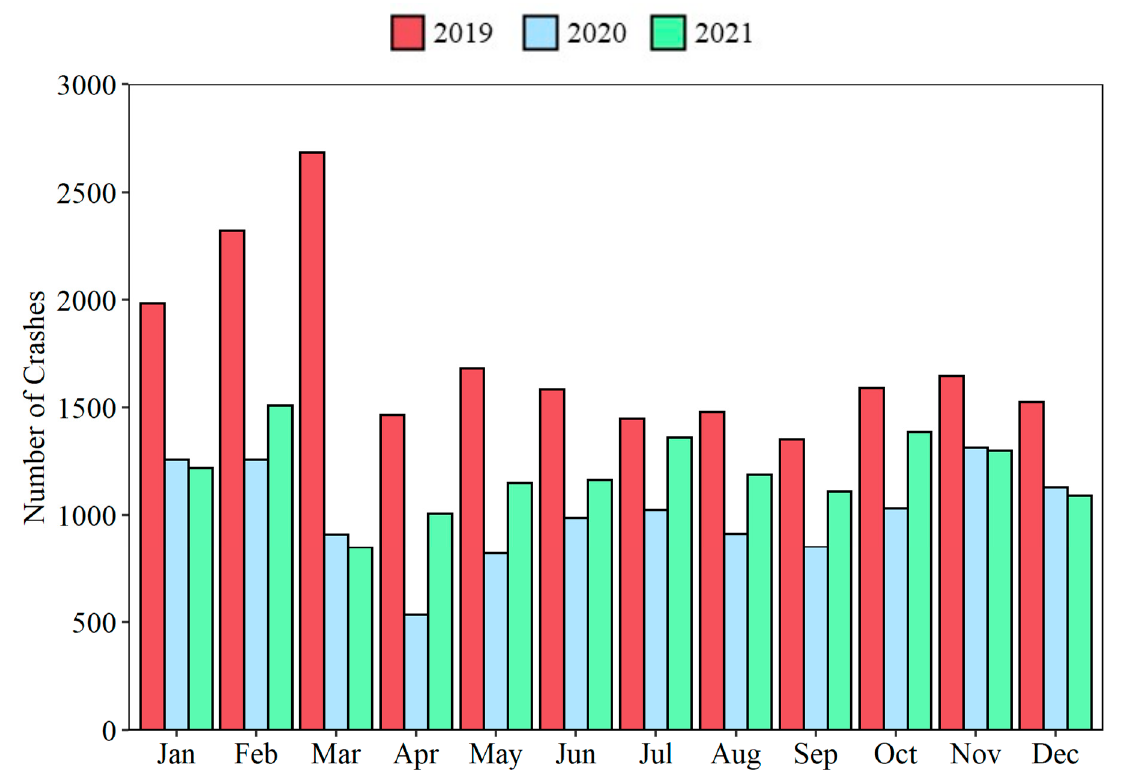
Figure 3. Monthly crash incidents on the Indiana interstate